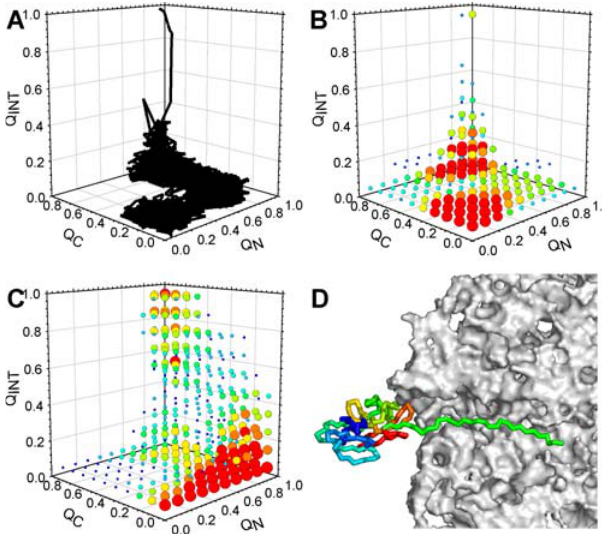
Figure 9. Folding of the Two-Domain Protein SFVP (A) Evolution of Q N , Q C , and Q INT during a typical refolding trajectory of the serine protease module of SFVP. (B) The most populated points in (Q N , Q C , Q INT ) space during 100 refolding trajectories. Each point in the (Q N , Q C , Q INT ) space is counted only once per trajectory in order to prevent repeated revisiting of the same region in a trajectory from biasing the results. Symbol size and color reflect relative population (large, red symbols being populated in 100% of simulations). (C) Same as (B), but for ten coupled synthesis–folding simulations. (D) Snapshot of the moment that native structure is cotranslationally formed; the green chain extending back to the peptidyltransferase active site represents the approximately 28 residues synthesized after the protease module’s final residue. DOI: